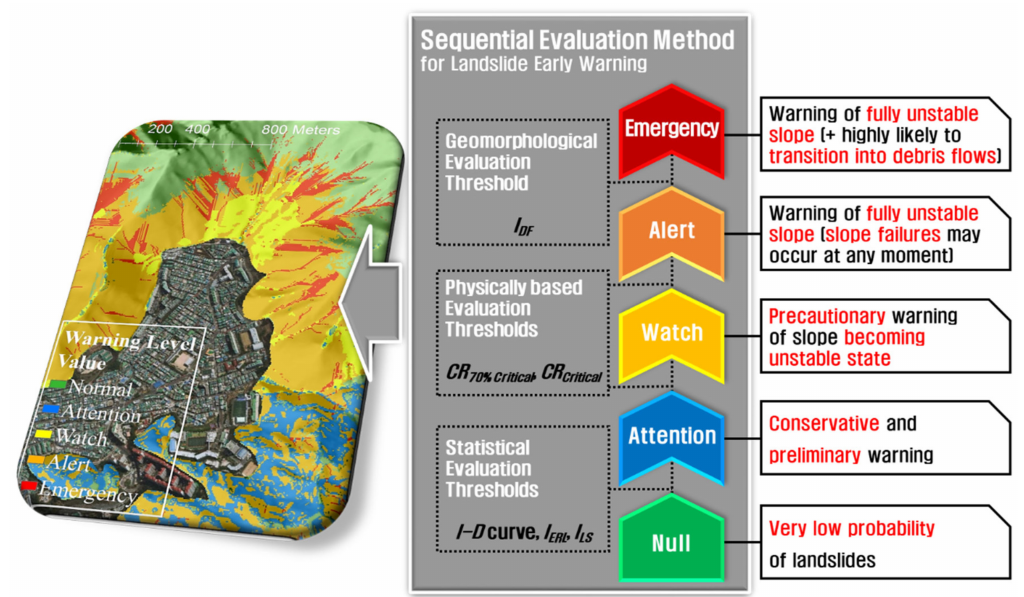
Figure 1. Conceptual diagram of the sequential evaluation method used for landslide early warnings, including three evaluation stages and hazard interpretations of each warning level